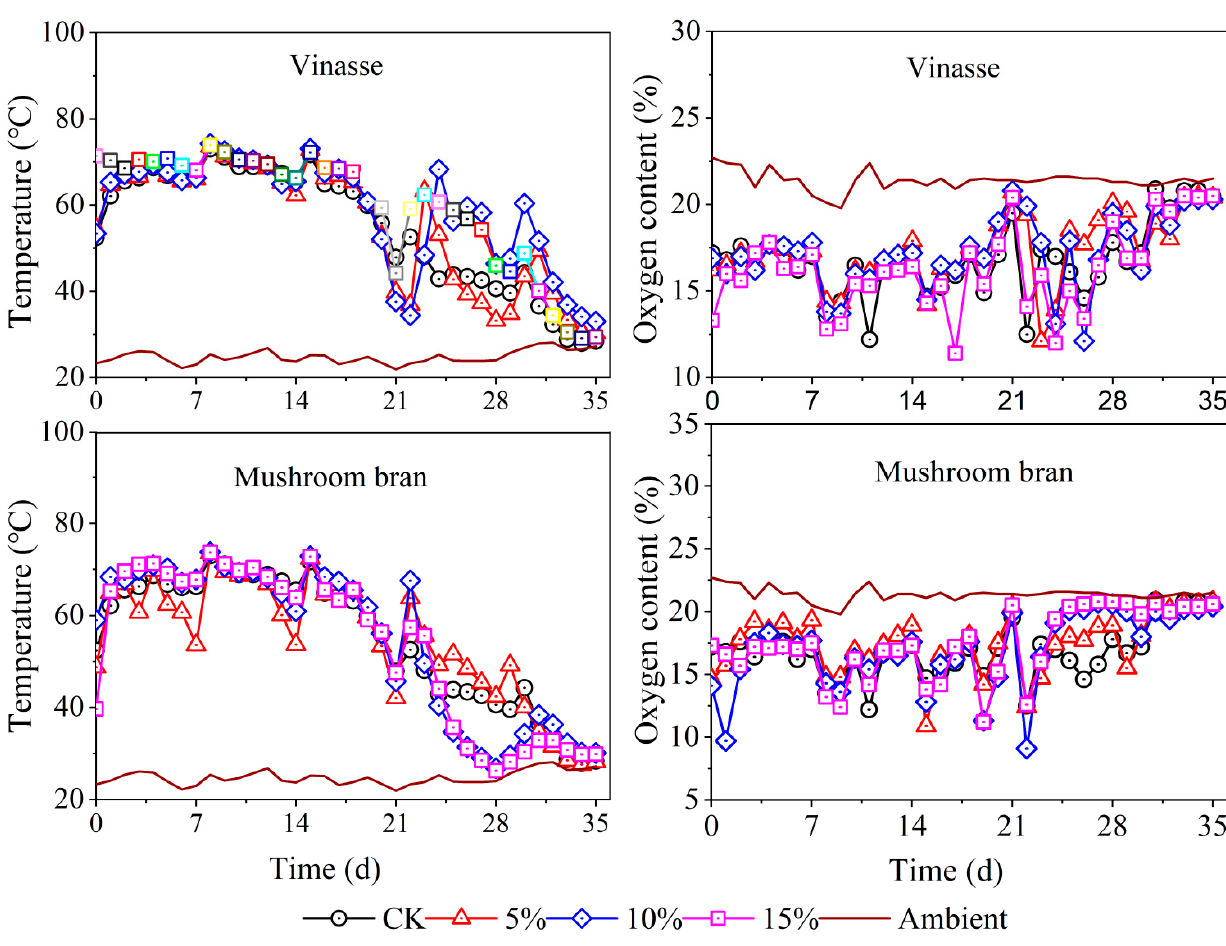
Figure 2. Variation of temperature and oxygen content during composting.